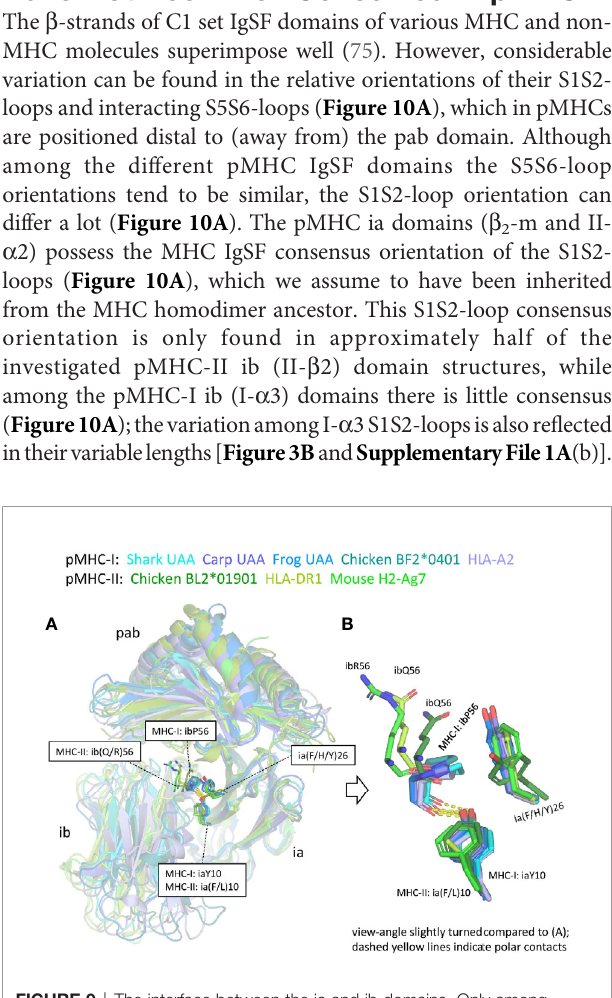
FIGURE 9 | The interface between the ia and ib domains. Only among pMHC-Is a set of interacting residues iaY10, ia(F/H/Y)26, and ibP56, is well conserved. (A) Superposition fi gure (based on superimposing of ia domains) with the sidechains of residues at the ia10, ia26, and ib56 positions highlighted in sticks format. For the ib56 residues also the main chains are shown in sticks format. (B) Enlarged view of these